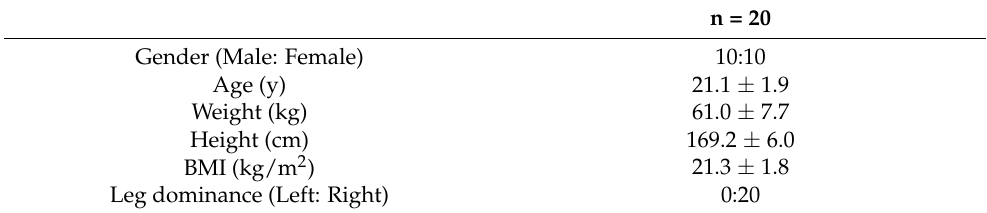
Table 1. Descriptive characteristics of the 20 participants.